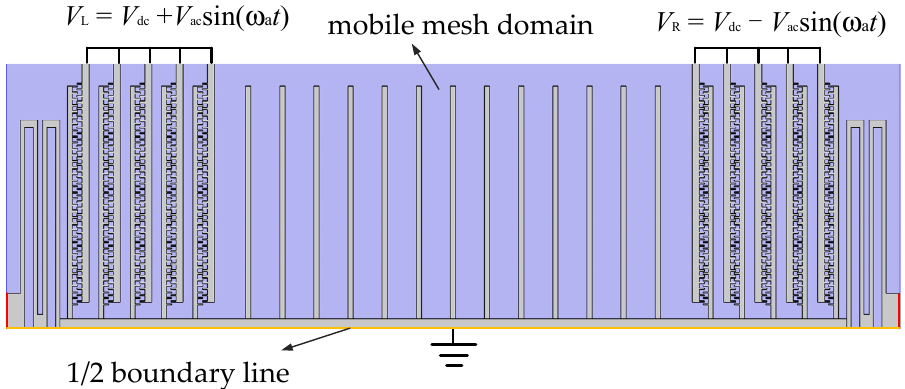
Figure 8. Schematic diagram of the electromechanical coupling model of the MEMS electric field sensor.